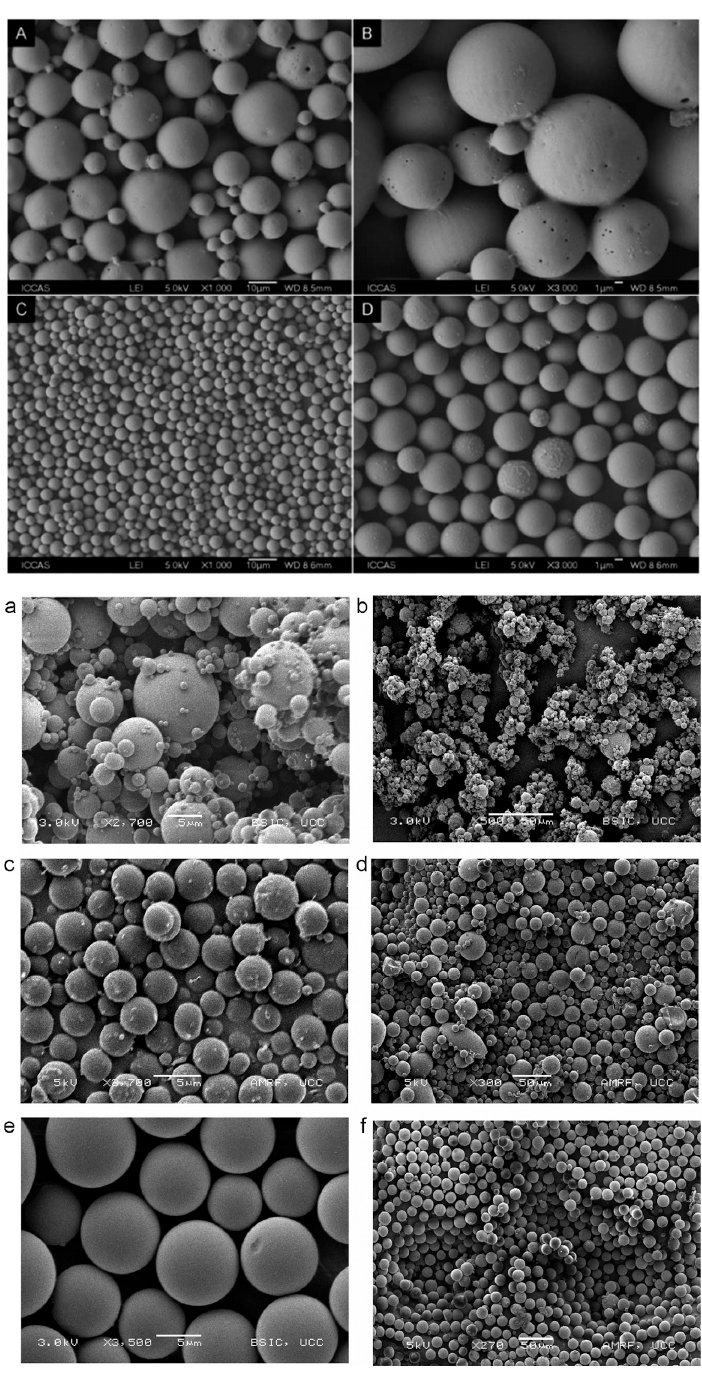
Figure 7. Scanning electron microscopic images of PLGA microparticles prepared using various processing techniques: ( A , B ) traditional W/O/W technique, ( C , D ) membrane emulsion method (Reproduced from Polymer Chemistry (2014), 5, Baoxia Liu, Xiao Zhou, Fei Yang, Hong Shen, Shenguo Wang, Bo Zhang, Guang Zhi, Decheng Wu, Fabrication of uniform sized polylactone microcapsules by premix membrane emulsification for ultrasound imaging, 1693–1701, with permission from the Royal Society of Chemistry [83]); ( a , b ) spray drying, ( c , d ) electrospray method ( e , f ) silicon microfluidic flow focusing device (MFFD). Among these techniques, MFFD produces the most uniform particles (Reprinted from International Journal of Pharmaceutics , 467, Kieran Keohane, Des Brennan, Paul Galvin, Brendan T. Griffin, Silicon microfluidic flow focusing devices for the production of size controlled PLGA-based drug loaded microparticles, 60–69, Copyright (2014), with permission from Elsevier [82]).